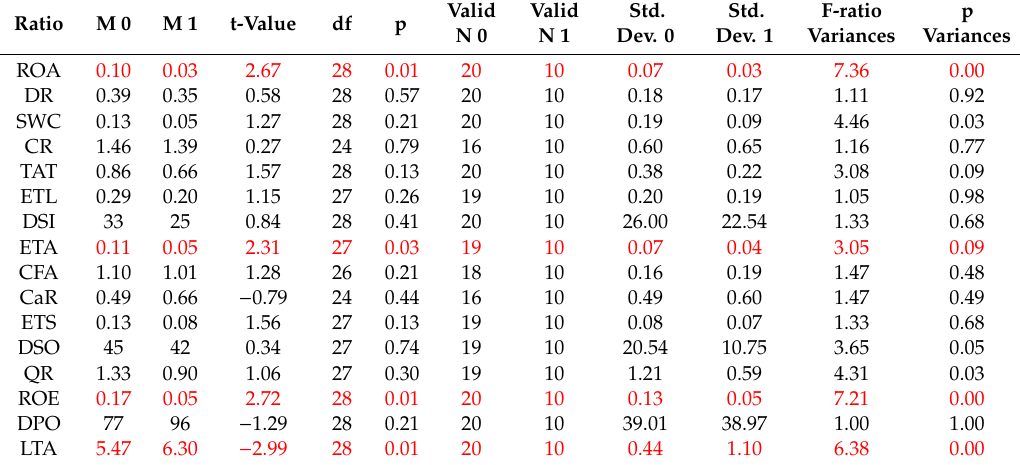
Table A10. The student’s t-test results for the chosen ratios for green (1) and red (0) companies for